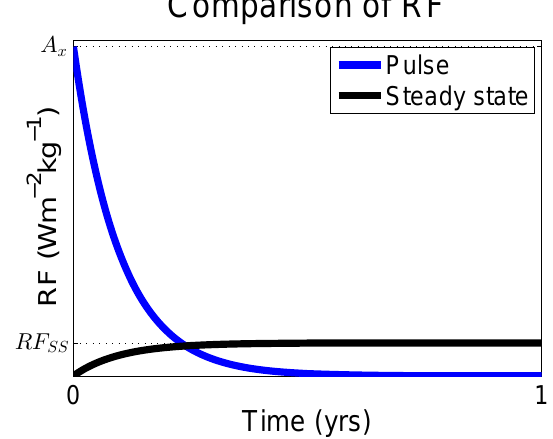
Fig. 5. For SLCFs with adjustment times much less than a year, the RF is usually calculated based on a sustained emission, RF SS , and then remapped back to the radiative efficiency, A x